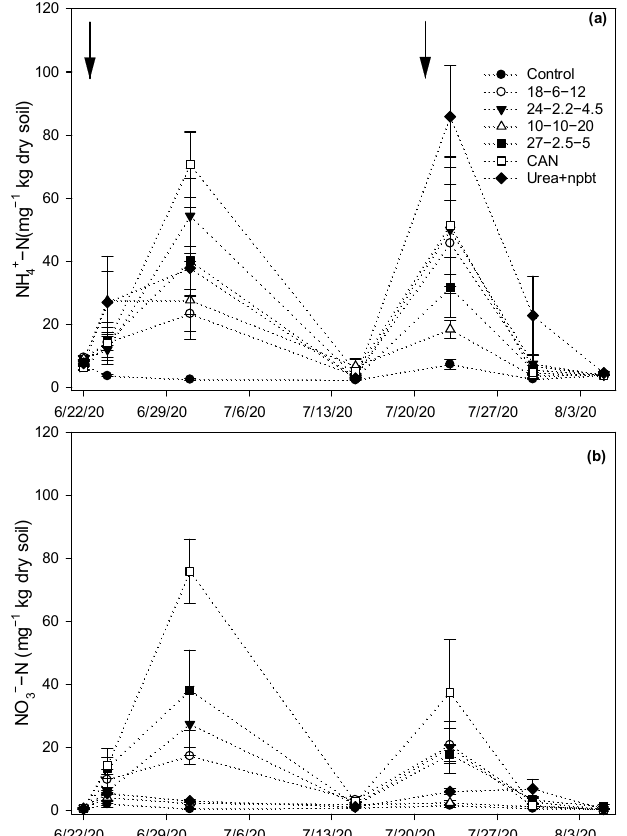
Figure 5. Average soil NH 4 + -N ( a ) and NO 3 − -N ( b ) concentrations measured from 0 to 10 cm soil depth during the experimental period. Arrows indicate application dates of fertilisers.